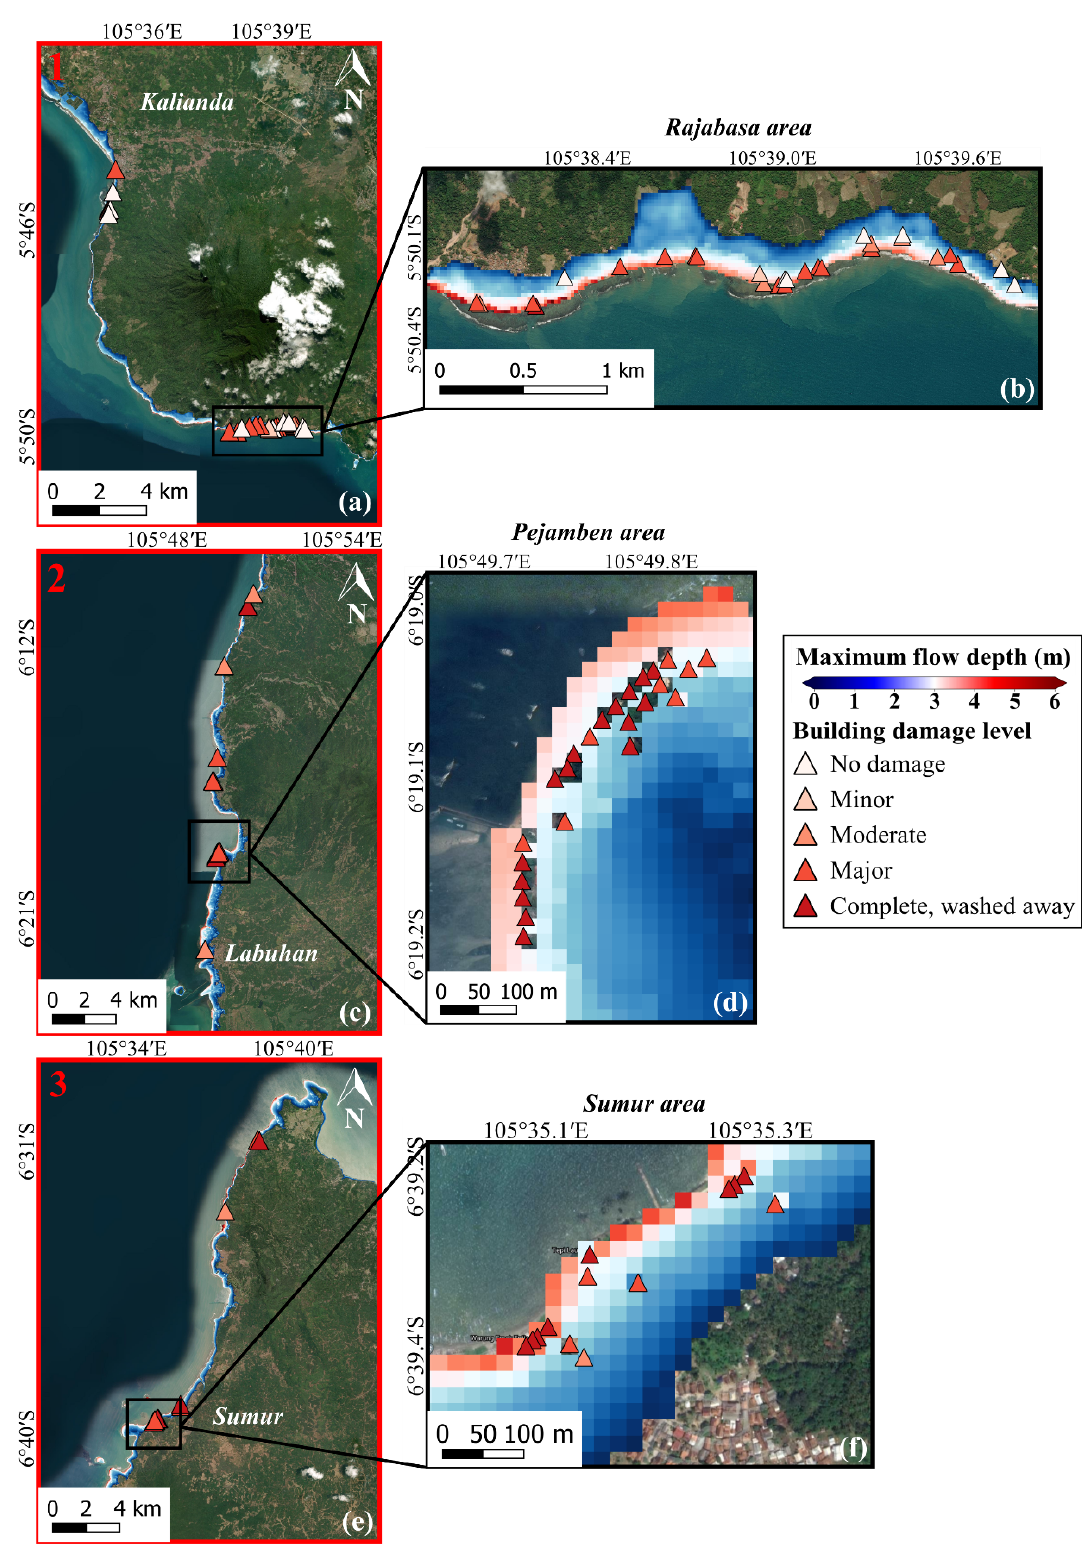
Figure 5. (a, c, and e) Sunda Strait final tsunami inundation model with the maximum simulated flow depth overlaid on the damaged building data in the computational areas 1 to 3, and (b, d, and f) magnified views of the maximum simulated flow depth in the Rajabasa, Pejamben, and Sumur areas (background ESRI and © Google